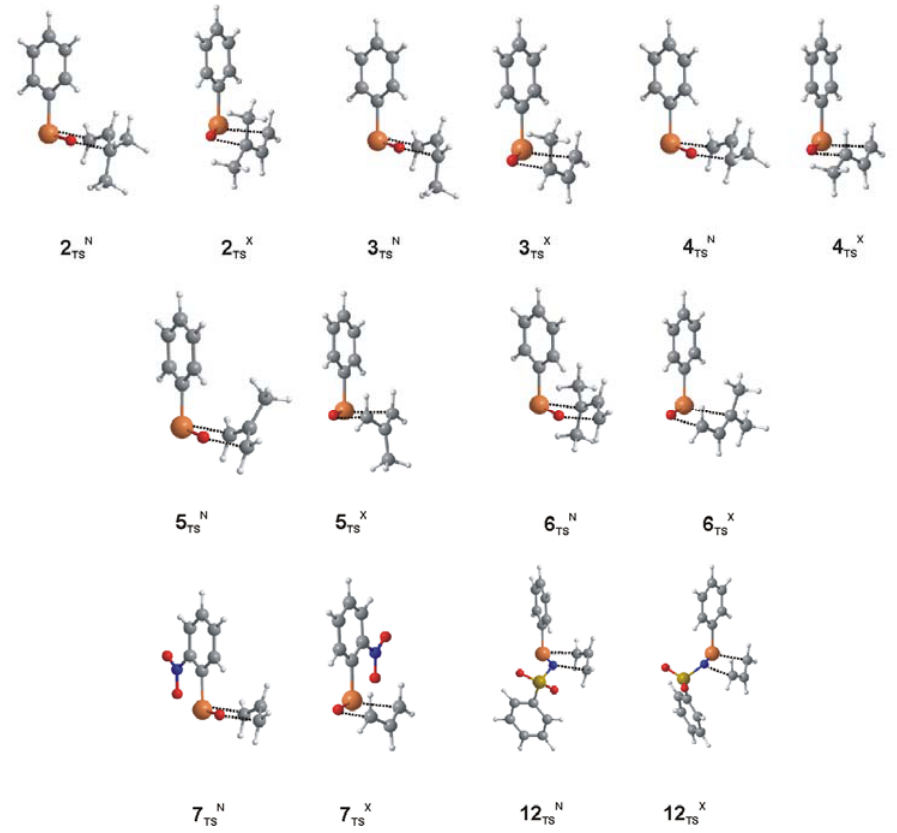
Figure 4. Optimized structures of the endo and exo transition states for 2 through 6 , 7 and 12